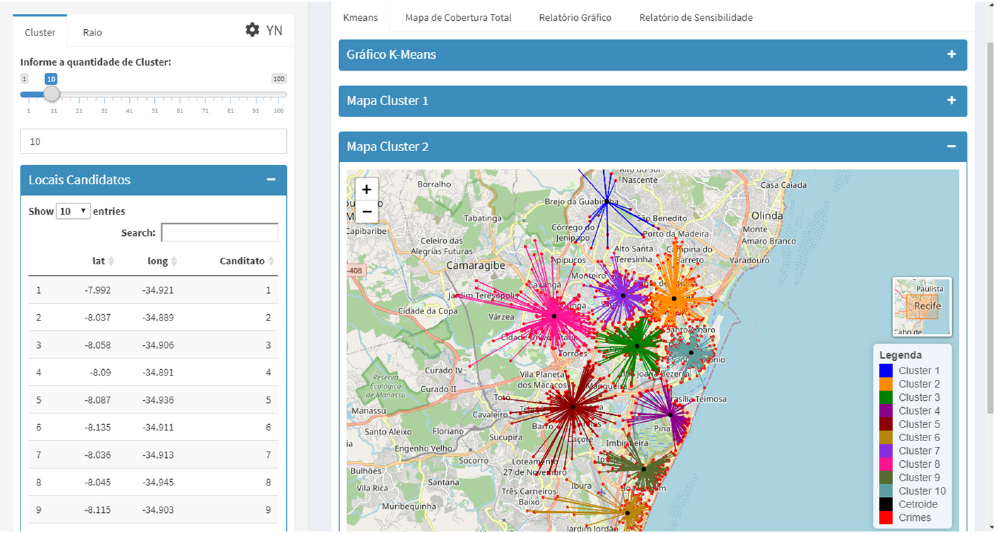
Figure 7. Criminal clusters in Recife. The centroid of each region delimited by the clusters is found using the proposed MIS. Each cluster’s centroid is a potential candidate location for a police facility. Table 1 presents the centroids’ information as geographic coordinates, with all ten candidate locations. Table 1. Candidate coordinates.